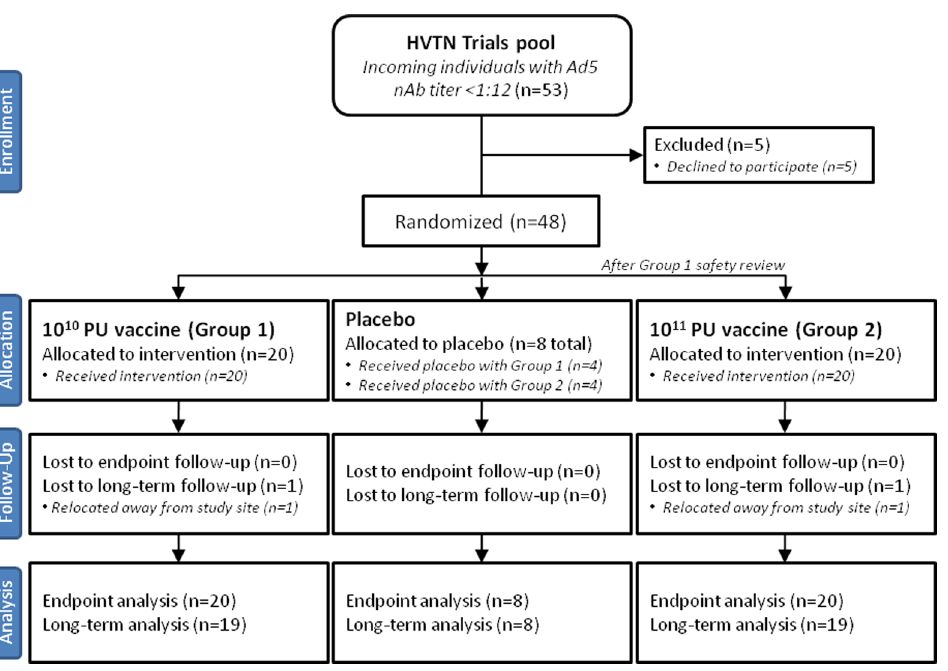
Figure 1. CONSORT statement 2010 flow diagram. Precise enrollment screening numbers are not available due to the candidate pool being screened for eligibility in multiple HVTN trials. Group 2 intervention proceeded only after a safety review of Group 1 interventions. For all analyses, both placebo groups were combined into one pool. Numbers shown in the analysis row are maximum available, with some specific assays using smaller numbers due to assay-specific losses, as detailed in the results.